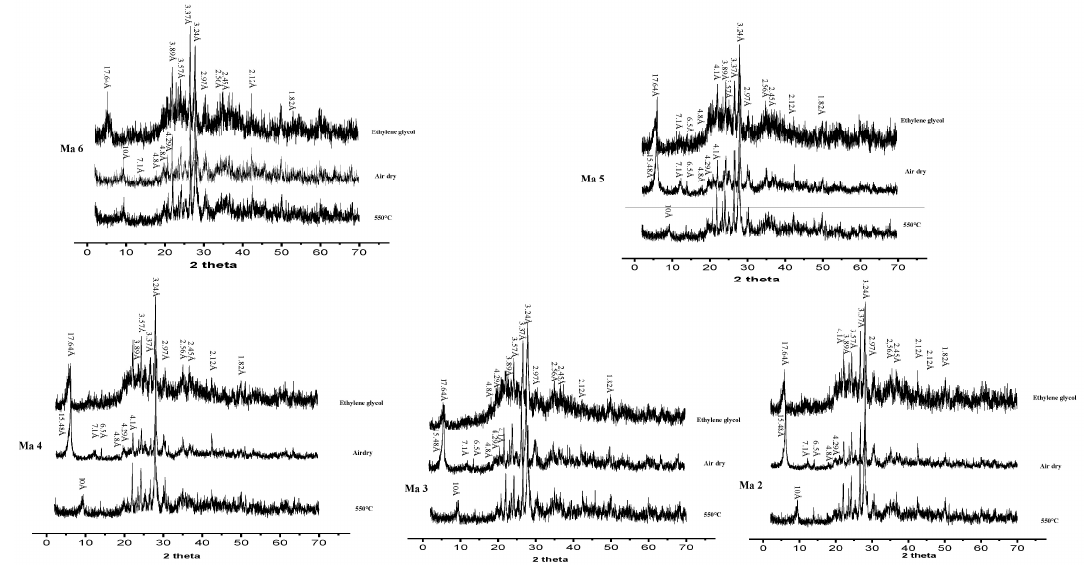
Figure 4. X-ray diffractograms for the studied soils from the Maroua region